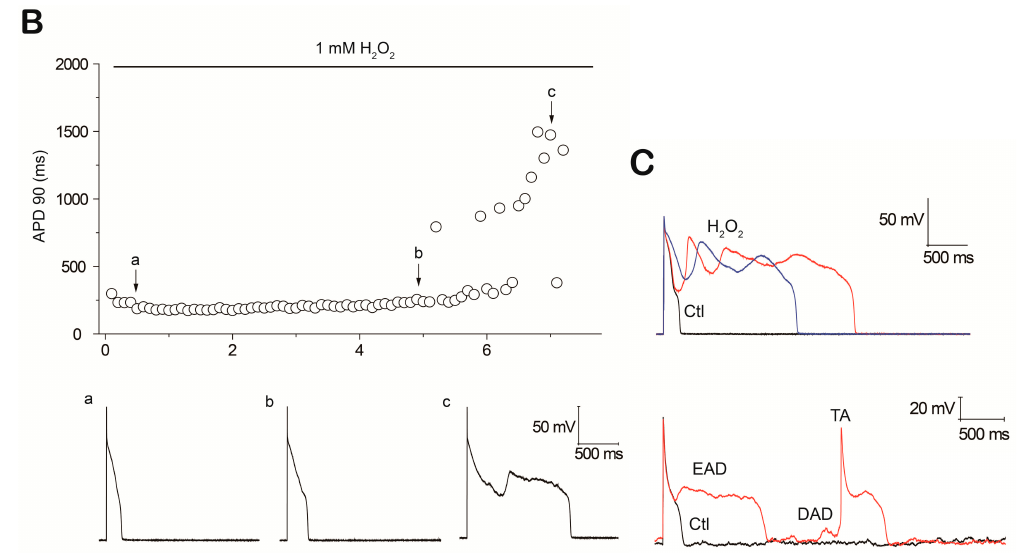
Figure 1. Afterdepolarizations induced by H 2 O 2 perfusion. ( A ) Action potentials (APs) were elicited consecutively at basic cycle lengths of 6 s and values of action potential durations (APD) 90 were plotted over time. APD 90 was consecutively recorded from a cell perfused with standard Tyrode solution for over 15 min. APs at 1 min (a), 10 min (b), and 15 min (c) are shown below. No early afterdepolarizations (EADs), delayed afterdepolarizations (DADs) or triggered activities (TAs) occurred; ( B ) H 2 O 2 (1 mM) was perfused continuously as indicated by the horizontal bar. APs at the beginning of the perfusion (a), and after perfusion with H 2 O 2 for 5 min (b) and 7 min (c) are shown below; ( C ) Examples of afterdepolarizations and TAs during H 2 O 2 exposure, including multiple oscillatory EADs (above), and different electrical abnormalities in a pacing cycle (below).